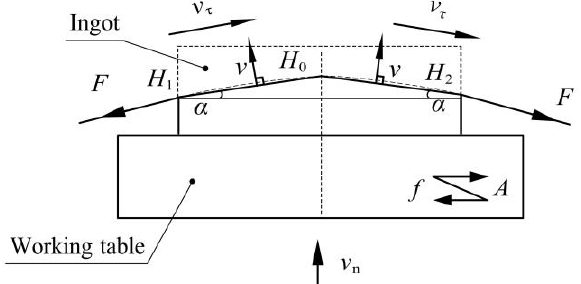
Figure 2. Deformation of the wire saw.